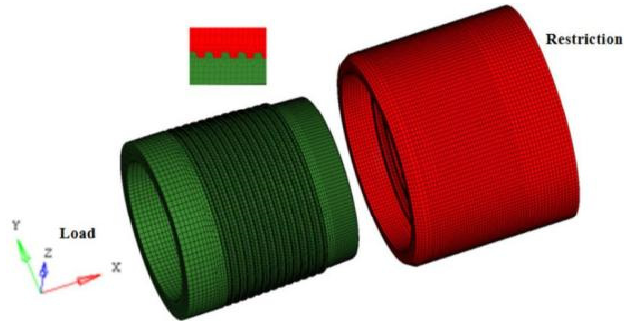
Figure 3. Boundary conditions. Table 3. Load cases.